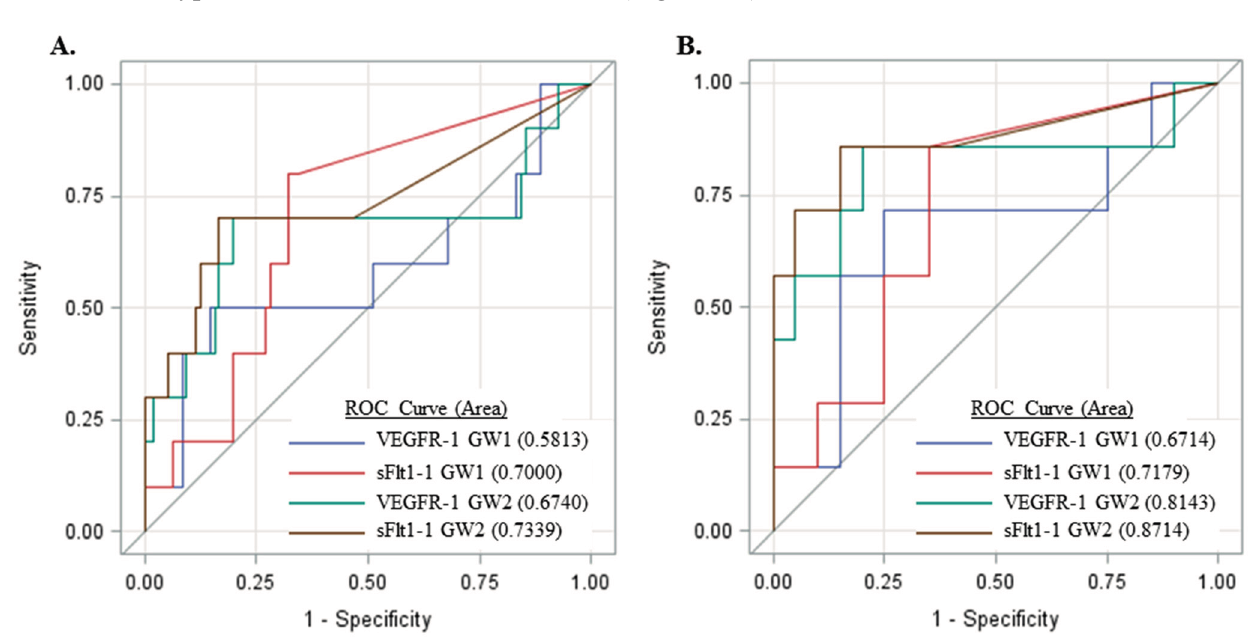
Figure 6. Receiver operator curves generated from the sensitivity and specificity of sFlt1-1 and VEGFR-1 preeclampsia predictions at gestational windows 1 and 2 in ( A ) all samples measured and ( B ) a high-risk subset of these women with chronic hypertension and/or diabetes